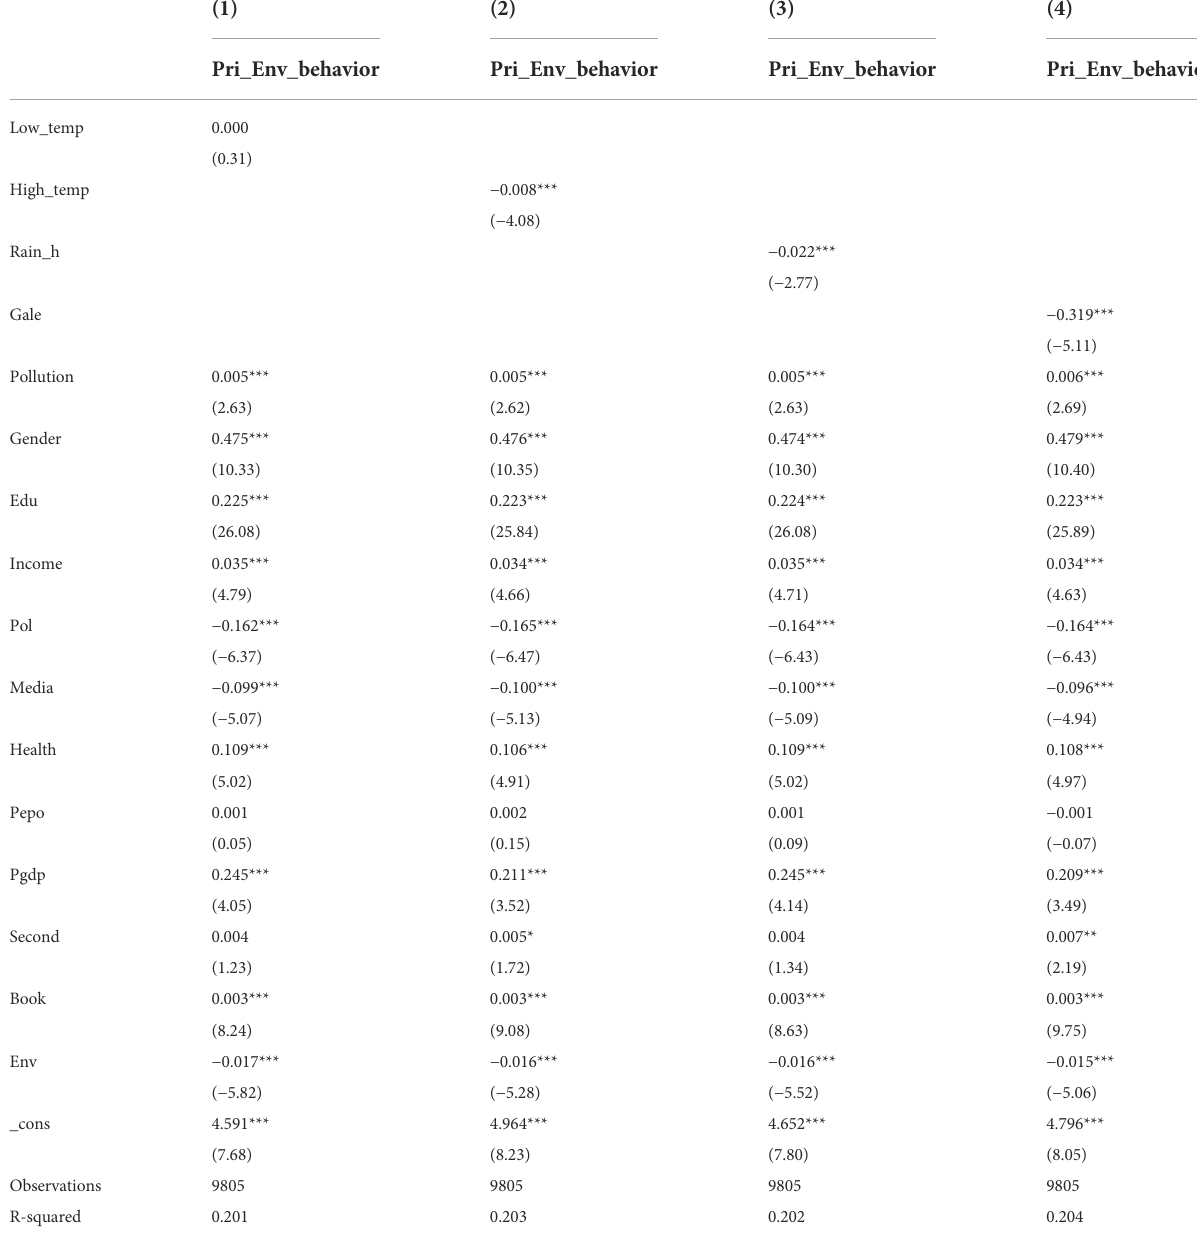
TABLE 5 Control of environmental pollution